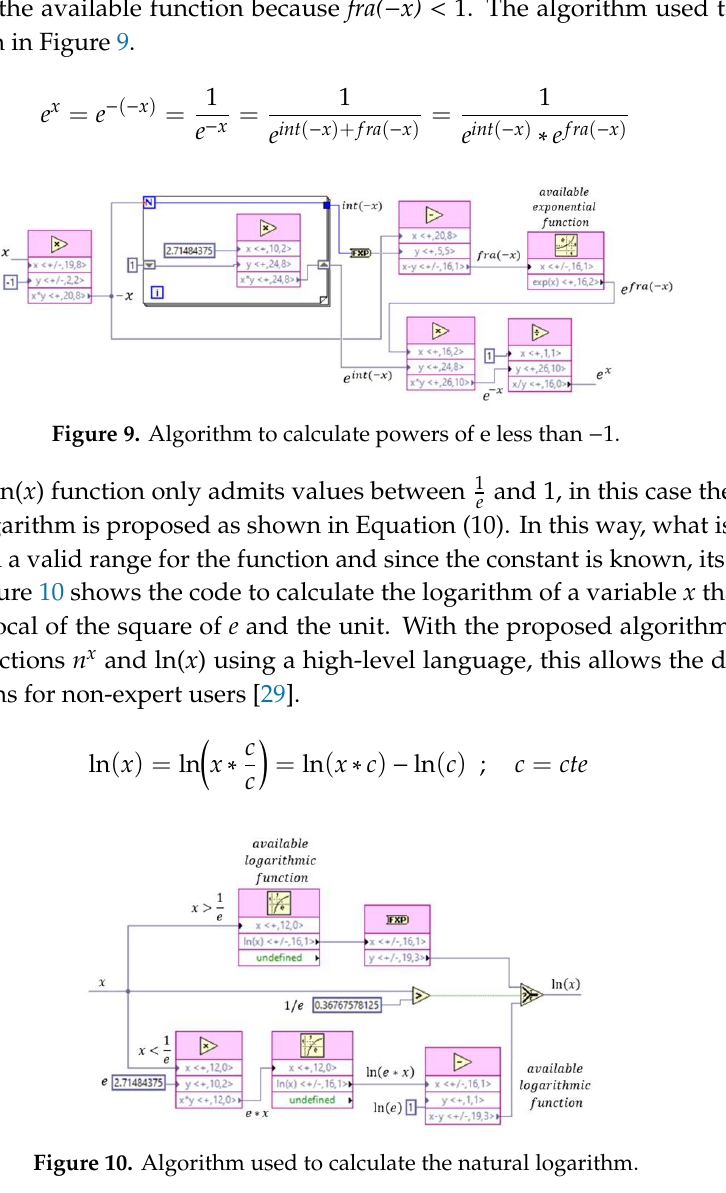
Figure 10. Algorithm used to calculate the natural logarithm.